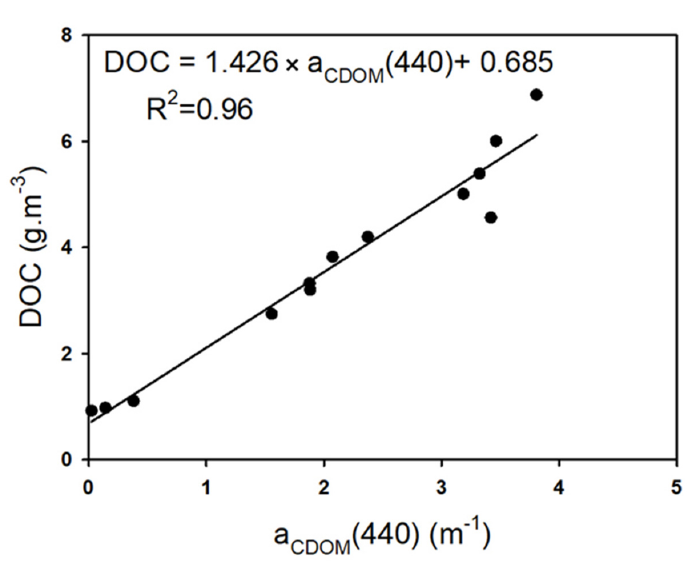
Figure 7. Relationship between Dissolved Organic Carbon concentration (DOC) and CDOM absorp- tion at 440 nm (a CDOM (440)) across Princess Charlotte Bay.